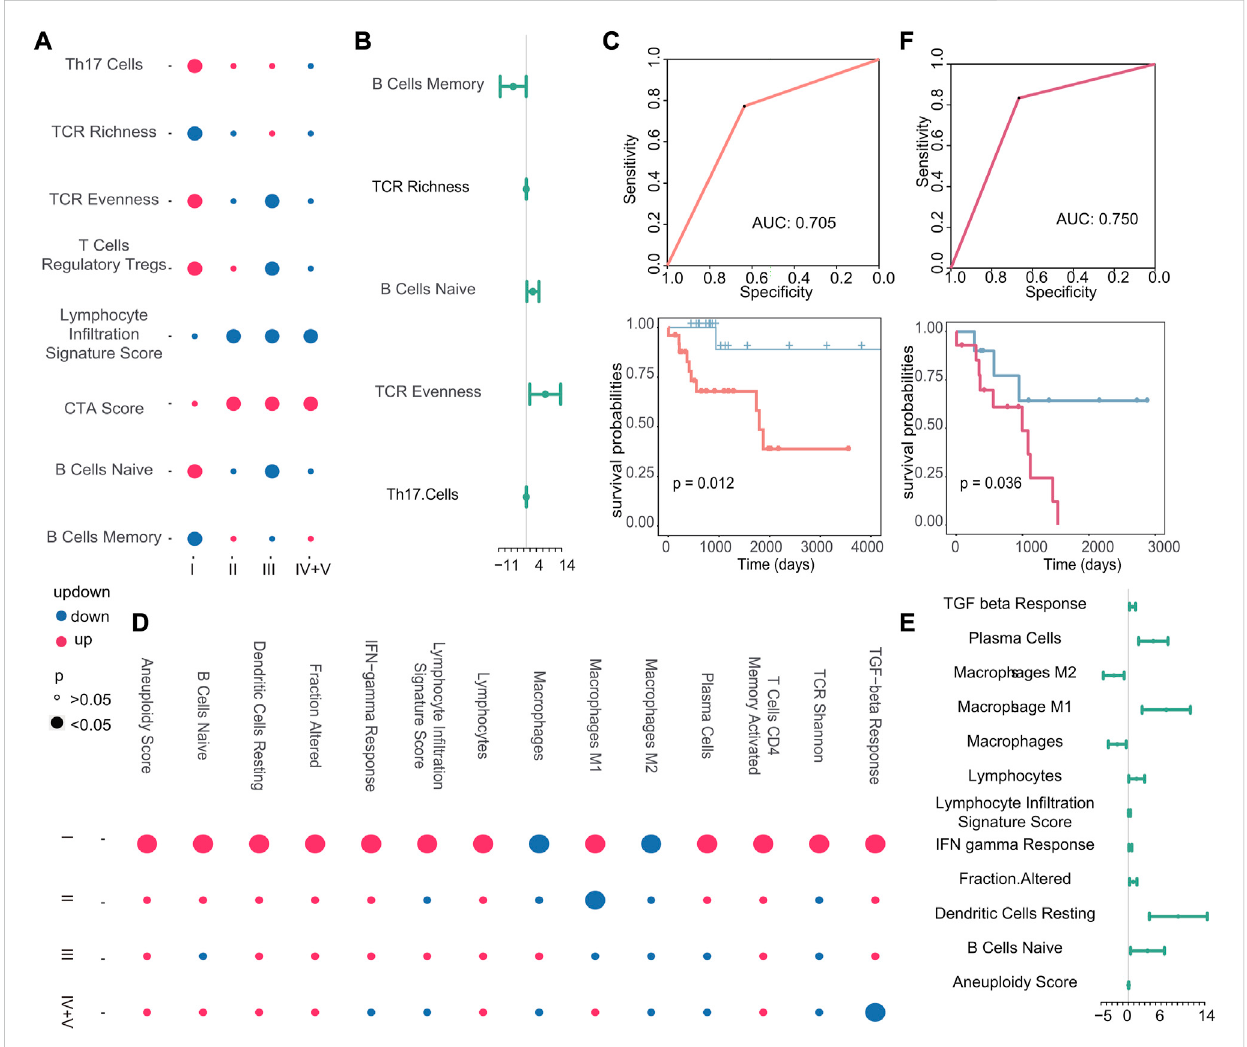
FIGURE 9 (A – D) DotplotsofstageI-speci fi cimmunecharacteristicsinrecurrentandmetastatictumors.Thecolorofthedotindicatesthechangeinthescore of the immune characteristics, and the size of the dot indicates the p -value. (B – E) Cox regression analysis of stage I-speci fi c immune characteristics in recurrentandmetastatictumors.Theendpointeventatthistimewasthegenerationofnewtumors.Thedotrepresentsthelogarithmictransformationof theHR value, and greater than 0indicates that it promoted the generation ofnew tumors. (C – F) Based on theimmune characteristics that promote thegenerationofnewtumors,theROCcurveoftheclassi fi erconstructedbyk-nearestneighborsandtheKaplan – Meiersurvivalcurveoftheresultofthe classi fi er. Red indicates samples predicted to develop metastasis, and blue indicates samples predicted to have no